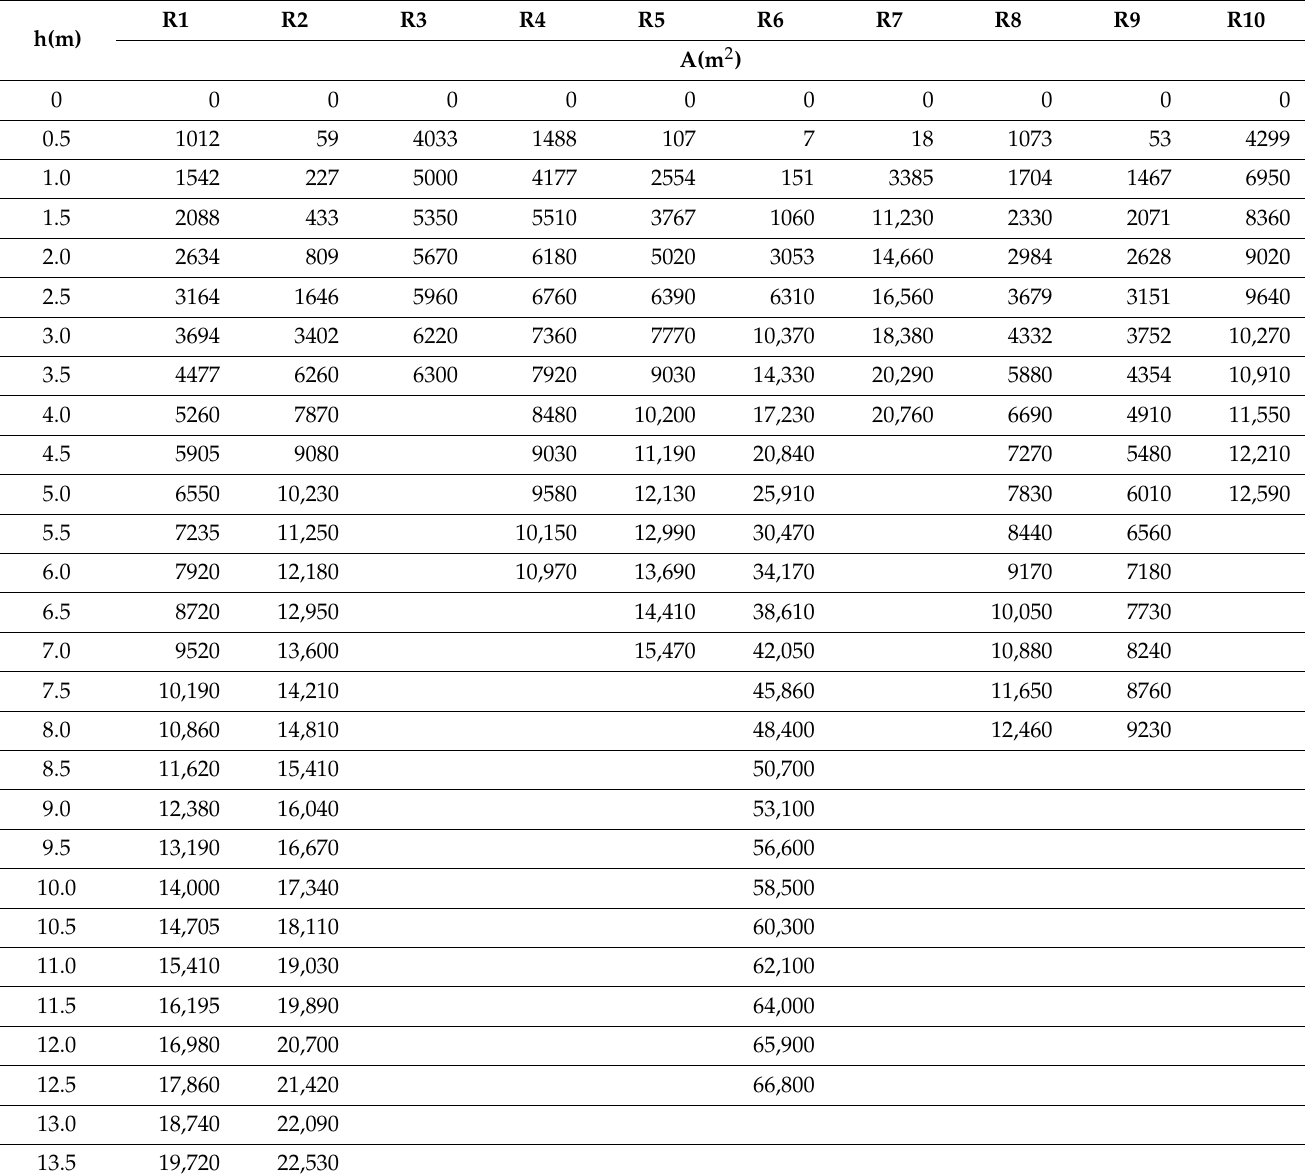
Table 1. Area measurements according to the change in reservoir